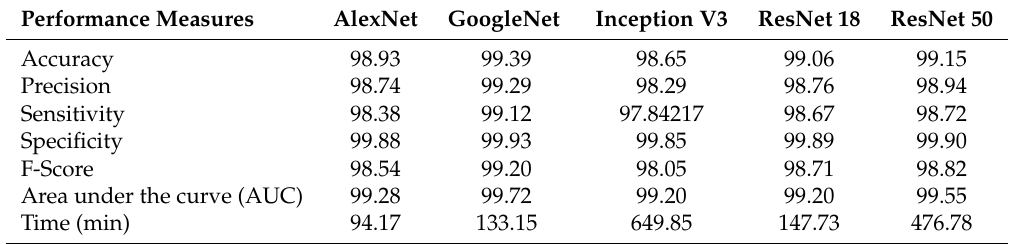
Table 6. Performance measures (%) for every pre-trained